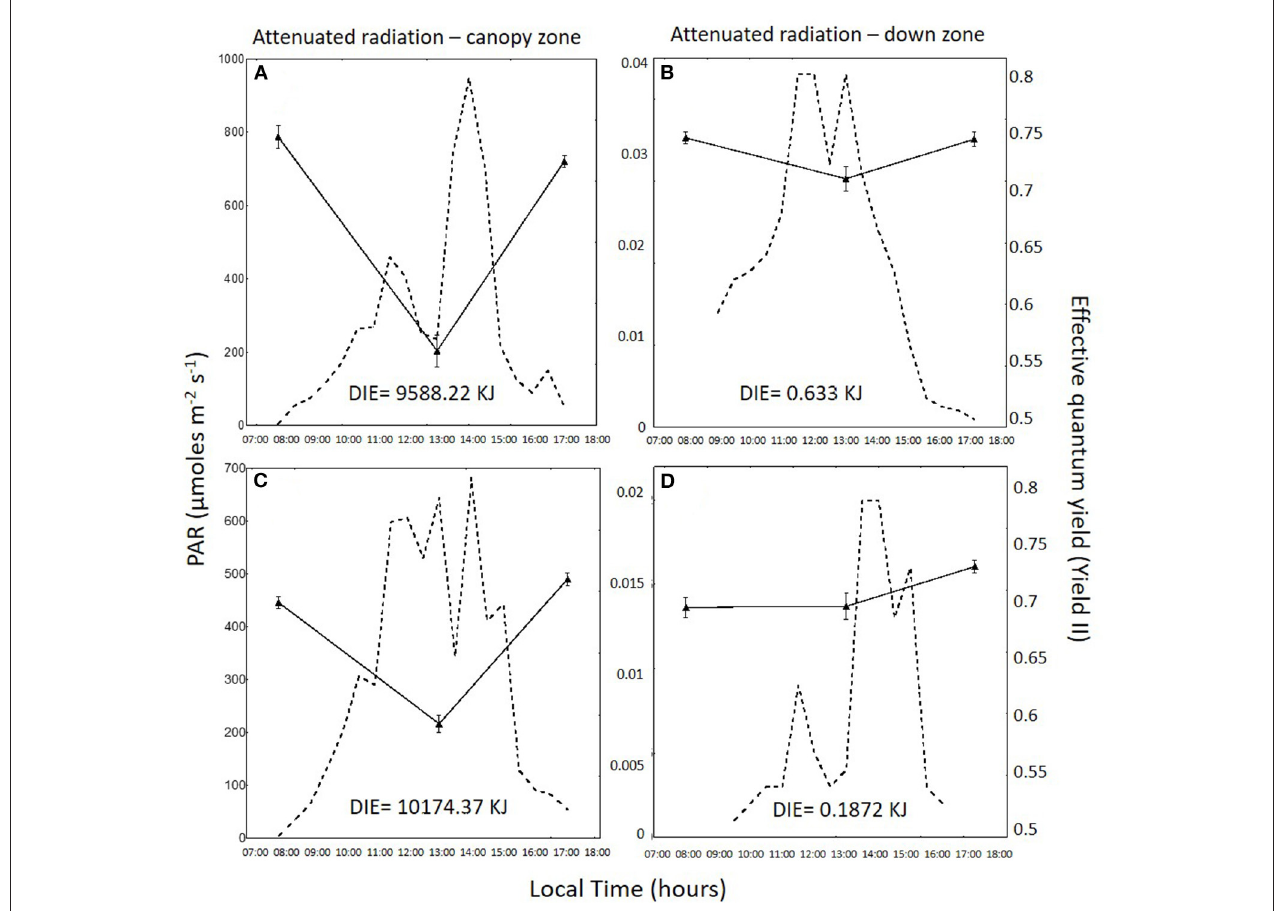
FIGURE 3 | Photosynthetically active radiation (PAR: 400–700nm, in µ mol photons m − 2 s − 1 , dotted lines) and the effective quantum yield ( Y II ) in Macrocystis pyrifera fronds (continuous lines) in the attenuated radiation treatment during the first daily cycle under the canopy zone (A) and the down zone (B) ; likewise, in the second daily cycle under the canopy zone (C) and the down zone (D)